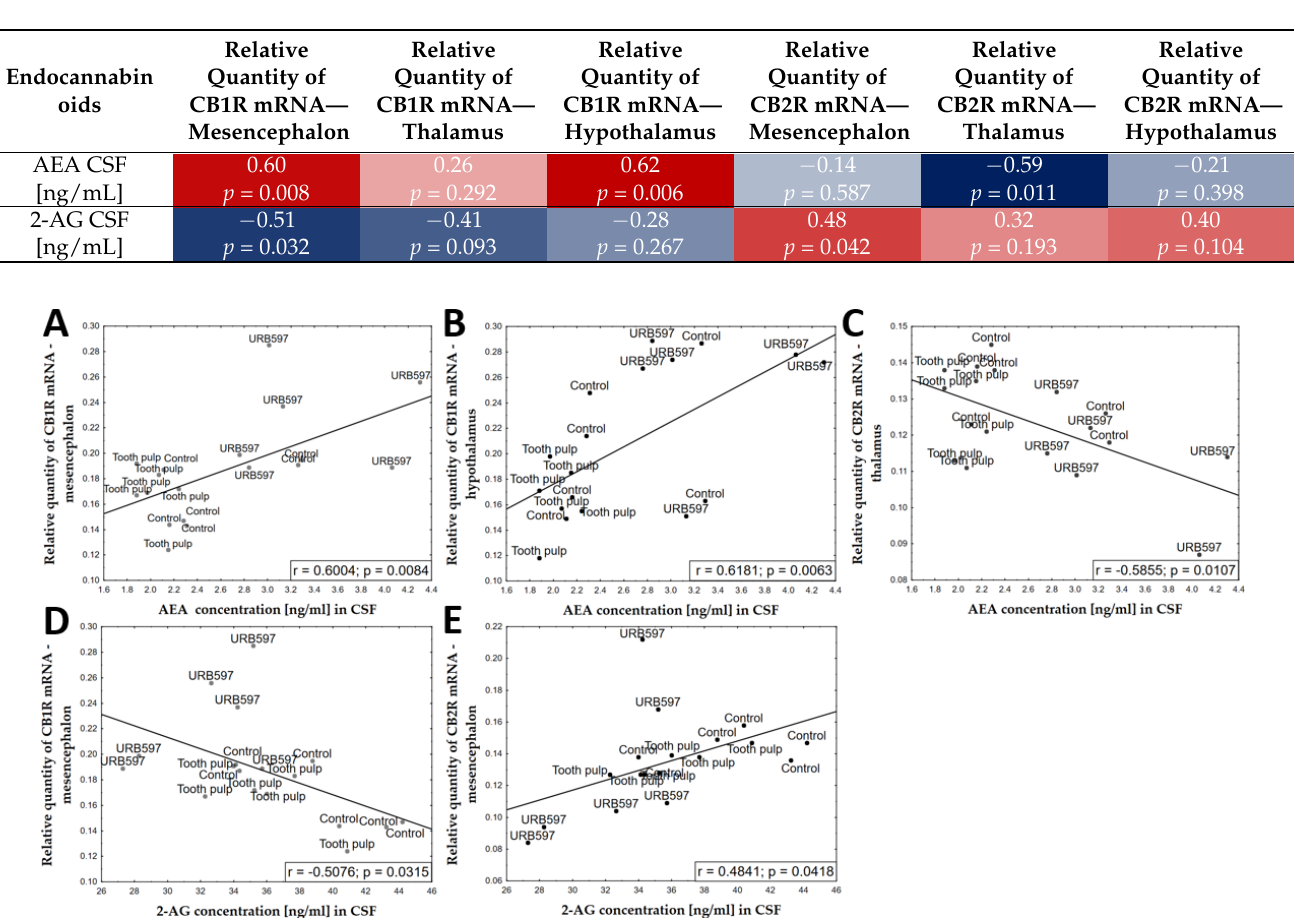
Figure 2. Statistically significant correlations between the concentrations of endocannabinoids in the CSF and cannabinoid receptor expression in the brain structures of rats: ( A ) correlation between AEA and CB1R expression in the mesencephalon, ( B ) correlation between AEA and CB1R expression in the hypothalamus, ( C ) correlation between AEA and CB2R expression in the thalamus, ( D ) correlation between 2-AG and CB2R expression in the mesencephalon, and ( E ) correlation between 2-AG and CB2R expression in the